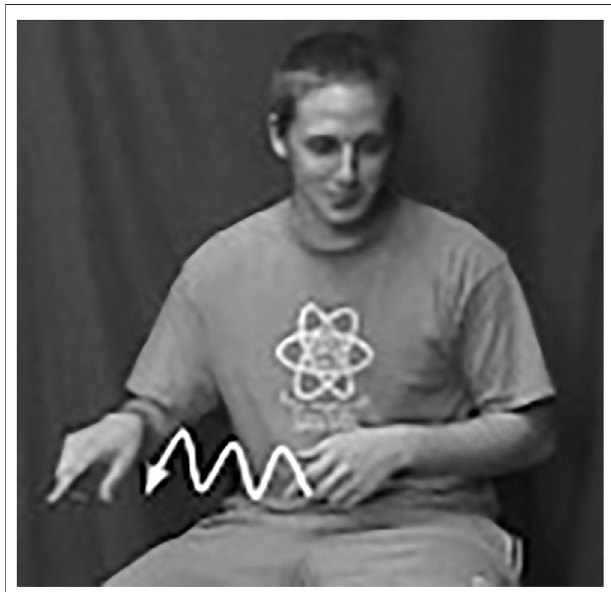
FIGURE 2 | Observer Viewpoint Gestures